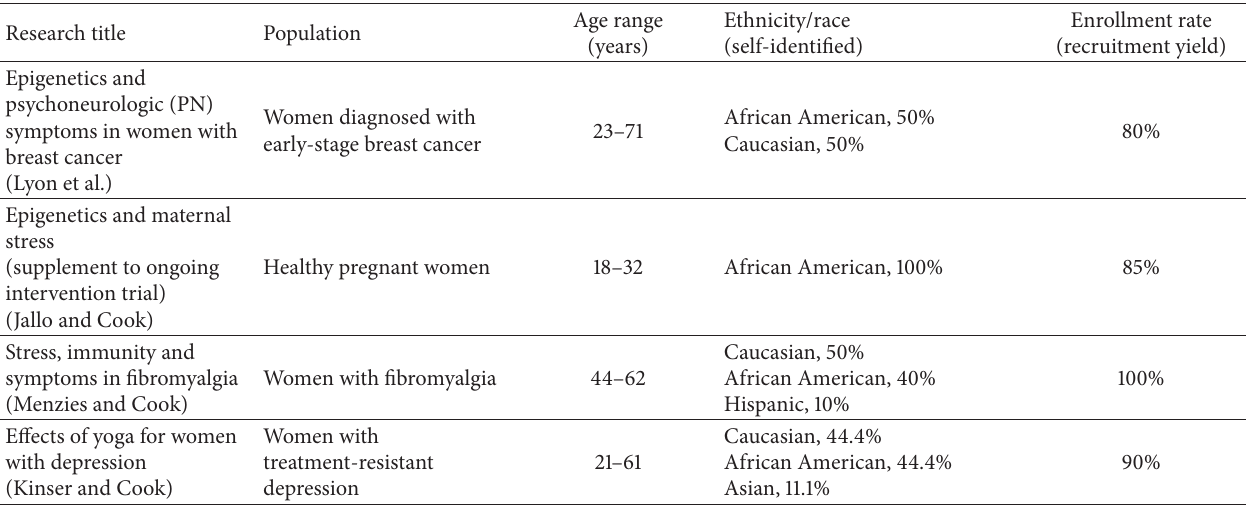
Table 2: Results of 4 research studies using the enhanced informed consent